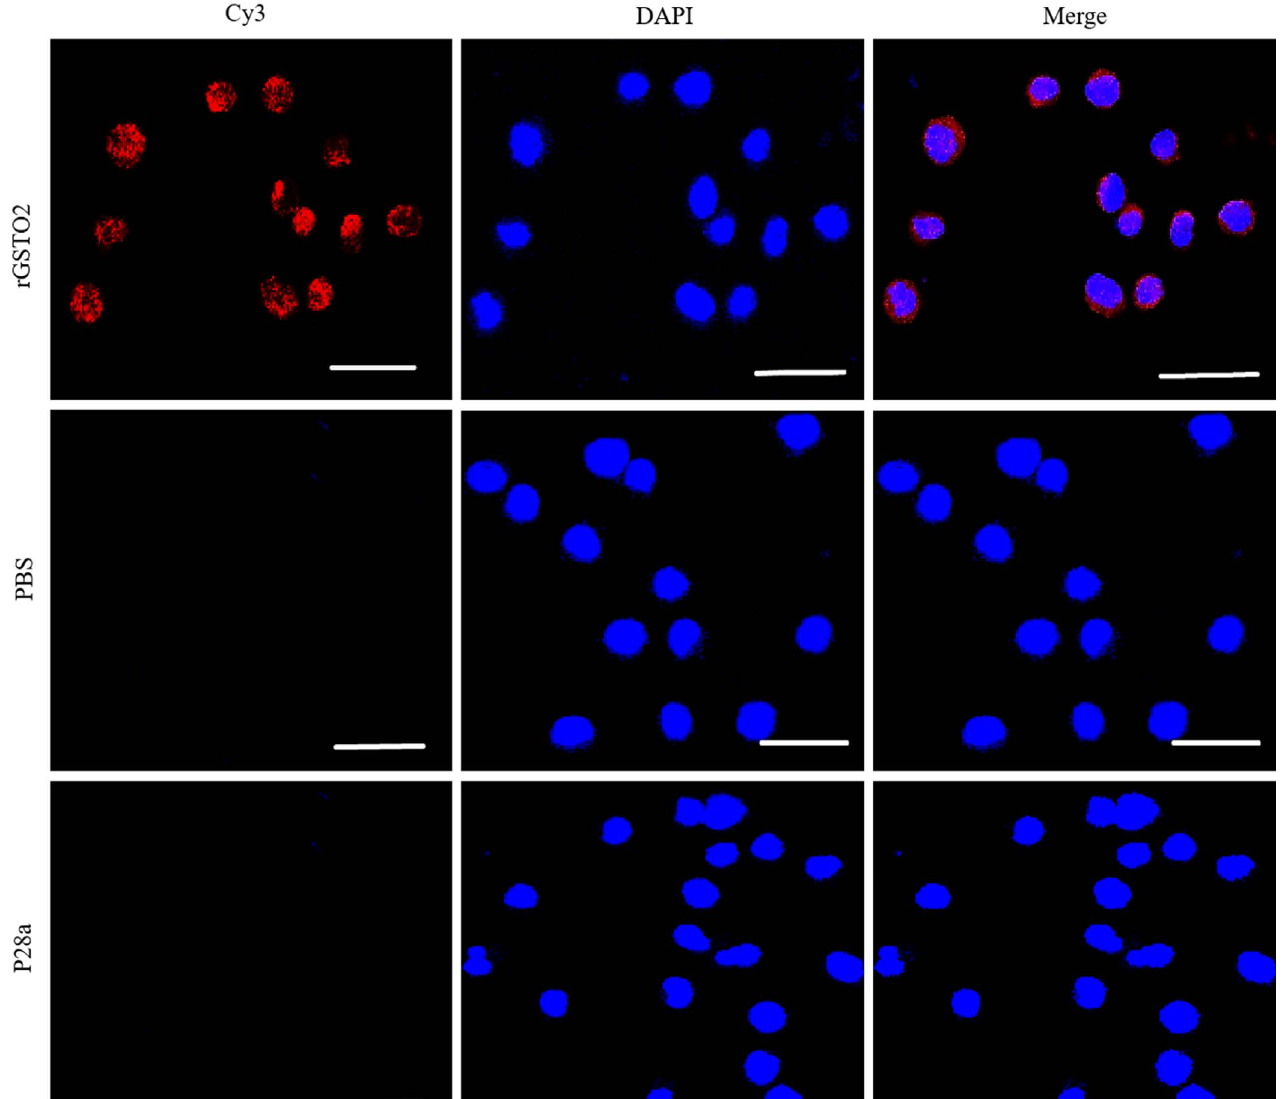
Figure 4. Localization of F. hepatica -derived rGSTO2 protein to the RAW264.7. macrophages surface. The macrophages were respectively pre-treated with rGSTO2, PBS or P28a protein, and the cells were then incubated with mouse anti-rGSTO2 IgG, naïve mouse serum or mouse anti-P28a IgG as primary antibody, followed by Cy3-conjugated goat anti-mouse IgG as the secondary antibody. The red fl uorescence on the surface of cells indicated that the target protein (rGSTO2 protein) is stained (Cy3) and the cell nuclei was stained by DAPI (blue), while merge represents the overlap of the red and blue fl uorescence channels. No fl uorescence was observed in PBS or P28a control groups. Scale-bars: 10 l m